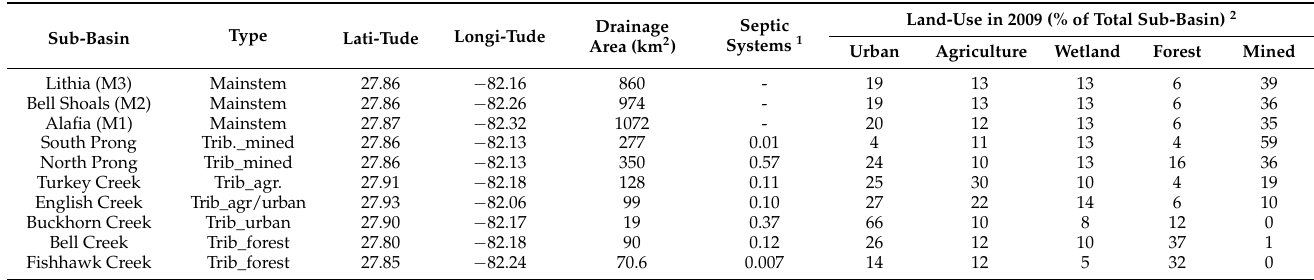
Table 1. Characteristics and land use in the Alafia River Watershed sub-basins located in central Florida, United States.